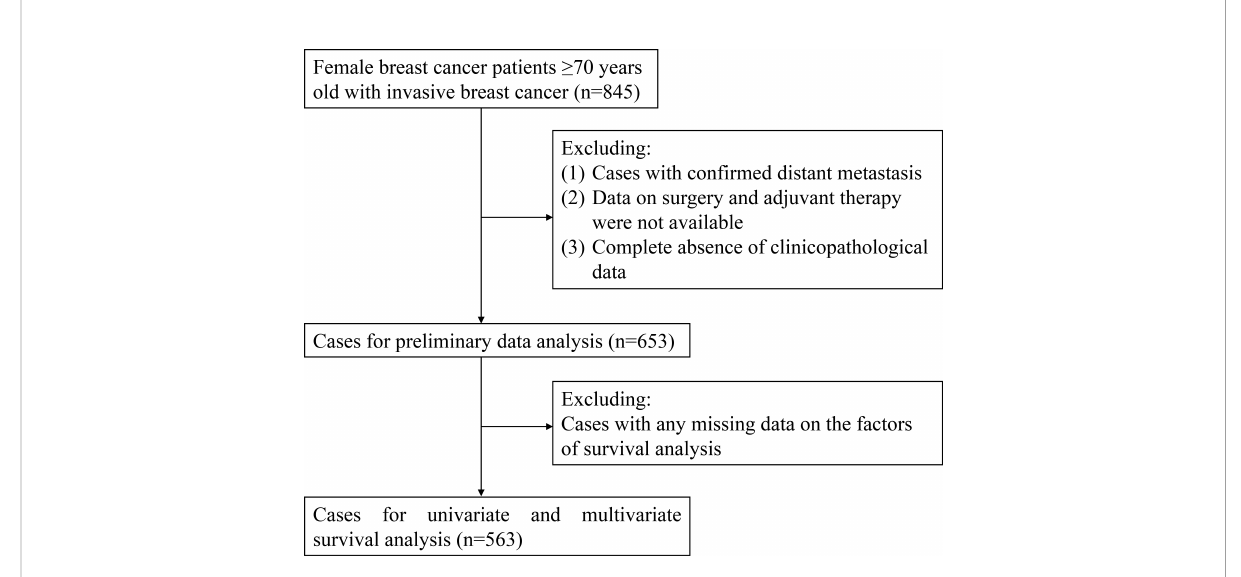
FIGURE 1 Flow diagram for case inclusion and